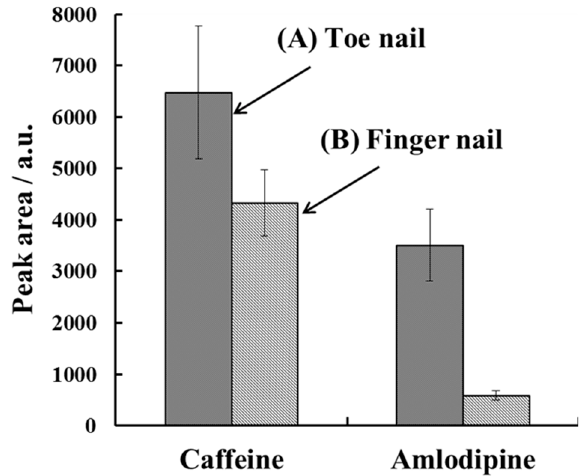
Comparison of the concentrations of caffeine and amlodipine in (A) toenails and (B) fingernails from a hypertension patient. The H-F heating extraction conditions were the same as in Figure 6A. Error bars represent the standard deviation ( n = 3).